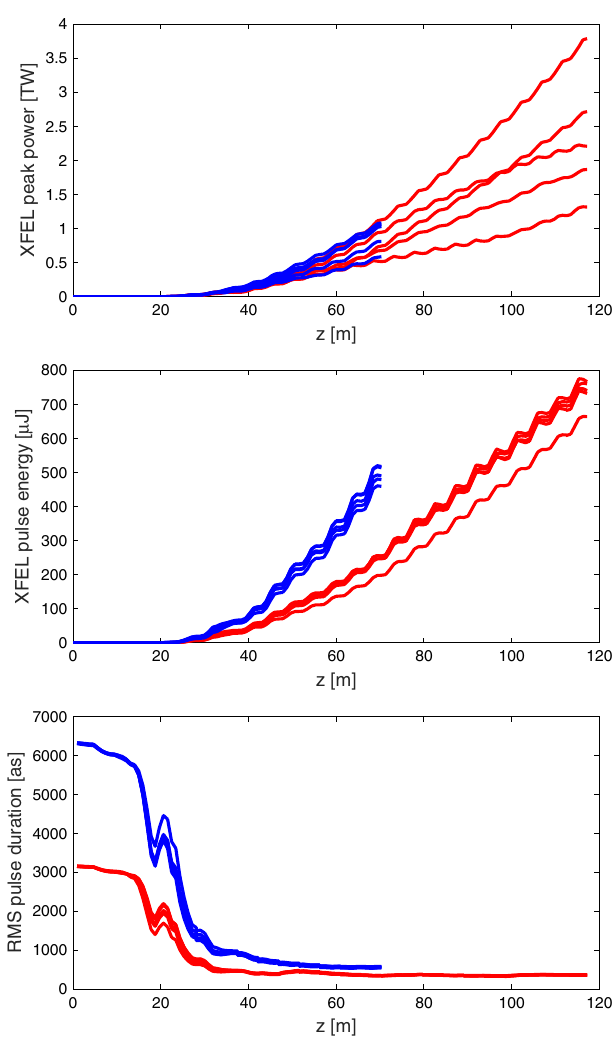
FIG. 4. XFEL peak power (top), XFEL pulse energy (center), and rms pulse duration (bottom) along the undulator beam line for the two simulated cases: initial tilt amplitude in offset of 50 with ten undulator sections (blue curves) and initial tilt amplitude in offset of 100 with 20 sections (red curves). We note that the rms pulse length is significantly affected by the spontaneous radiation background until z ≈ 30